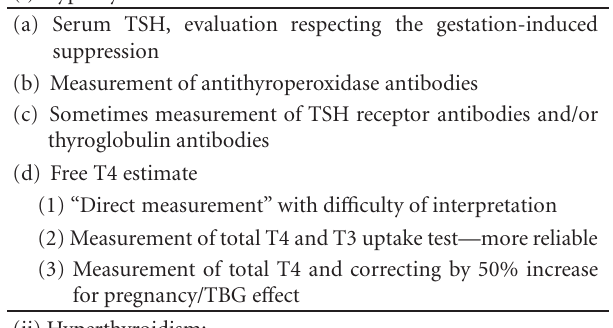
Table 2: Whatto do in clinicalpractice concerning thyroid function tests in pregnancy, when diagnosing hypo- or hyperthyroidism,